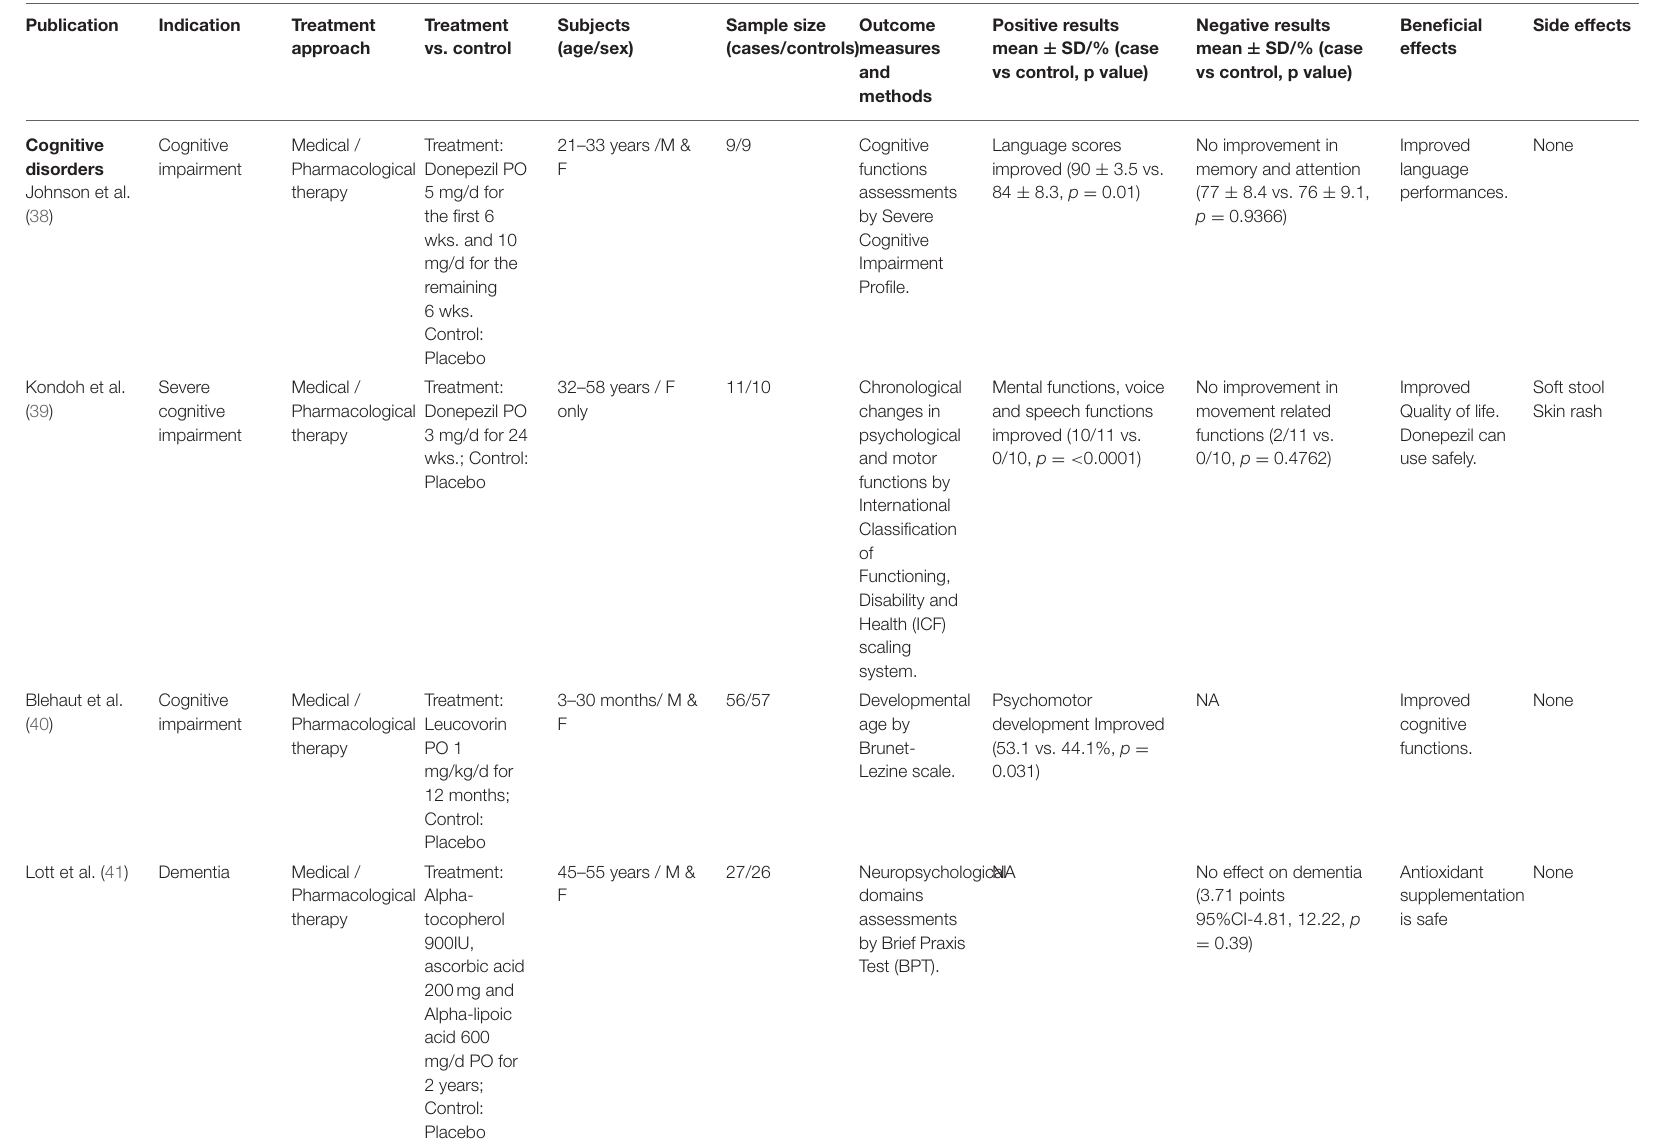
TABLE 2 | Postnatal therapy for individuals with Down’s